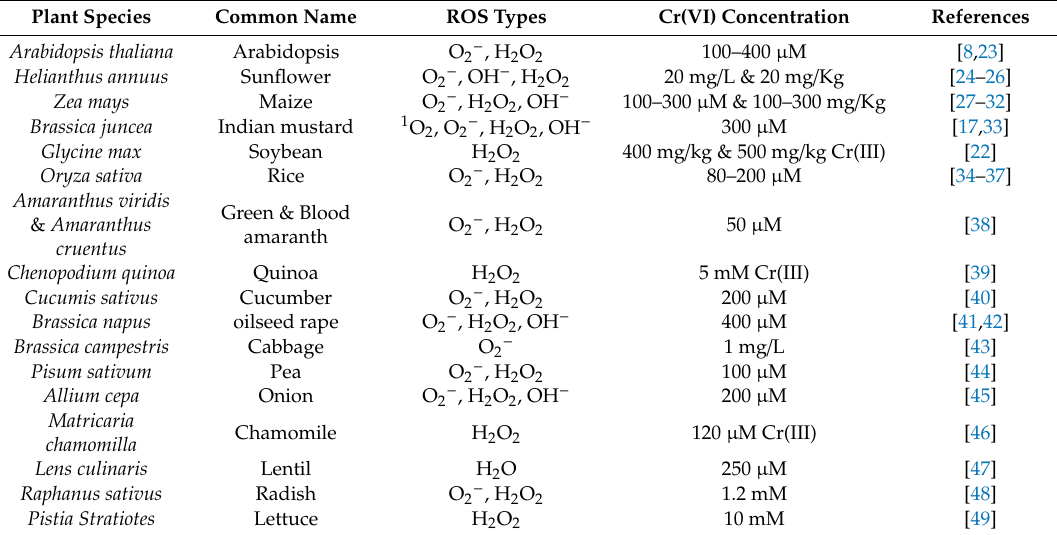
Table 1. Accumulations and investigations of various ROS species in numerous plant species exposed to Cr(VI) and / or Cr(III). Superoxide (O 2 − ), hydrogen peroxide (H 2 O 2), hydroxyl ion (HO − ), and singlet oxygen ( 1 O 2